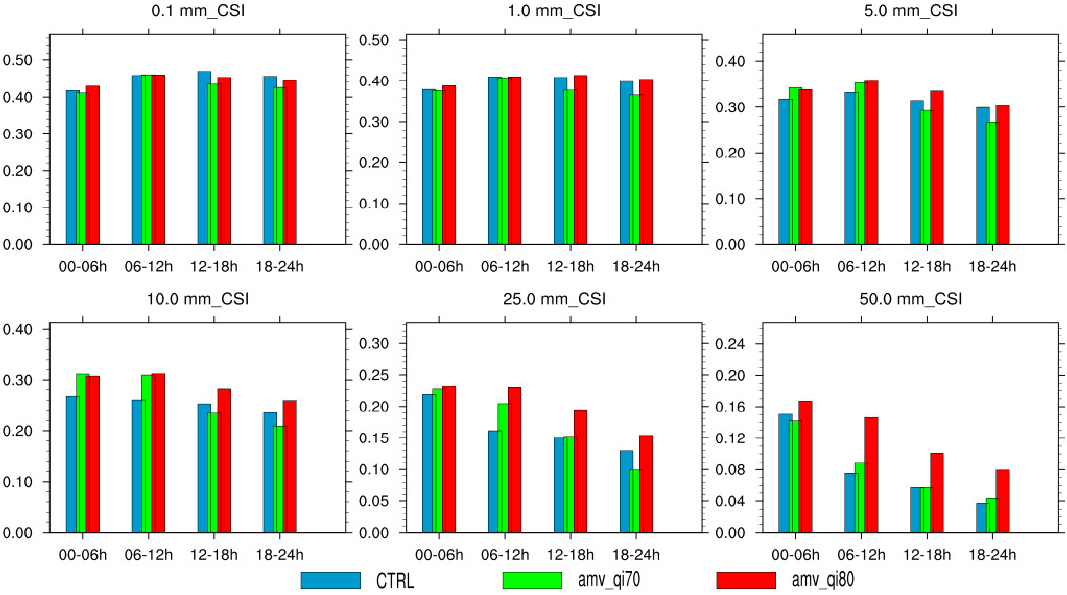
Figure 9. The CSI score of 6 h accumulated precipitation over the 3 km domain from the three experiments of the CTRL, amv_qi70 and amv_qi80 for the thresholds of 0.1 mm, 1.0 mm, 5.0 mm, 10.0 mm, 25.0 mm and 50.0 mm.